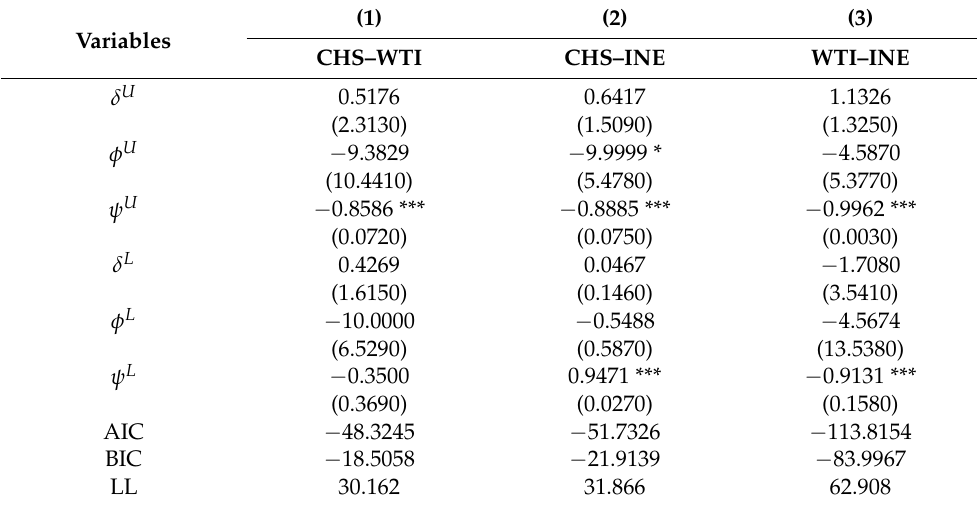
Table 5. Estimation results of the time-varying SJC-Copula model for paired markets (total sample).